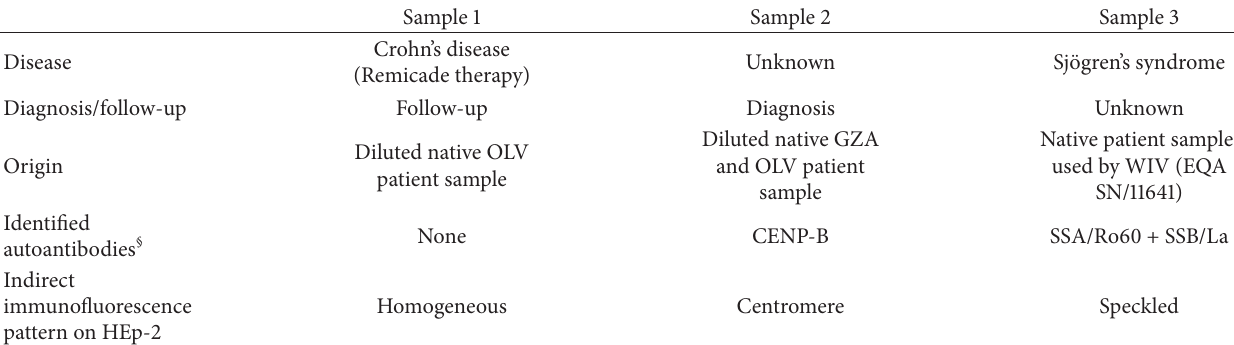
Table 1: Summary of the main sample characteristics of the samples included in the